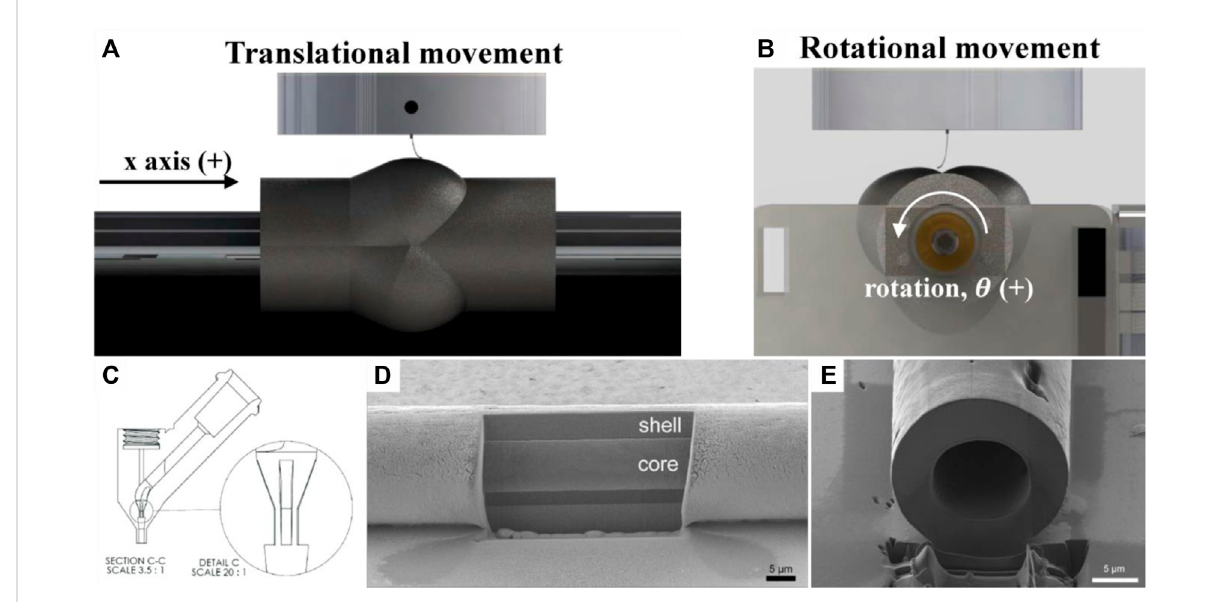
FIGURE 6 CylindricalMEW printing bed withaorticsinus features (A,B) (Saidy etal.,2020),coaxial nozzle (C) for hollow MEW fi ber fabrication (D,E) (Eberle et al.,